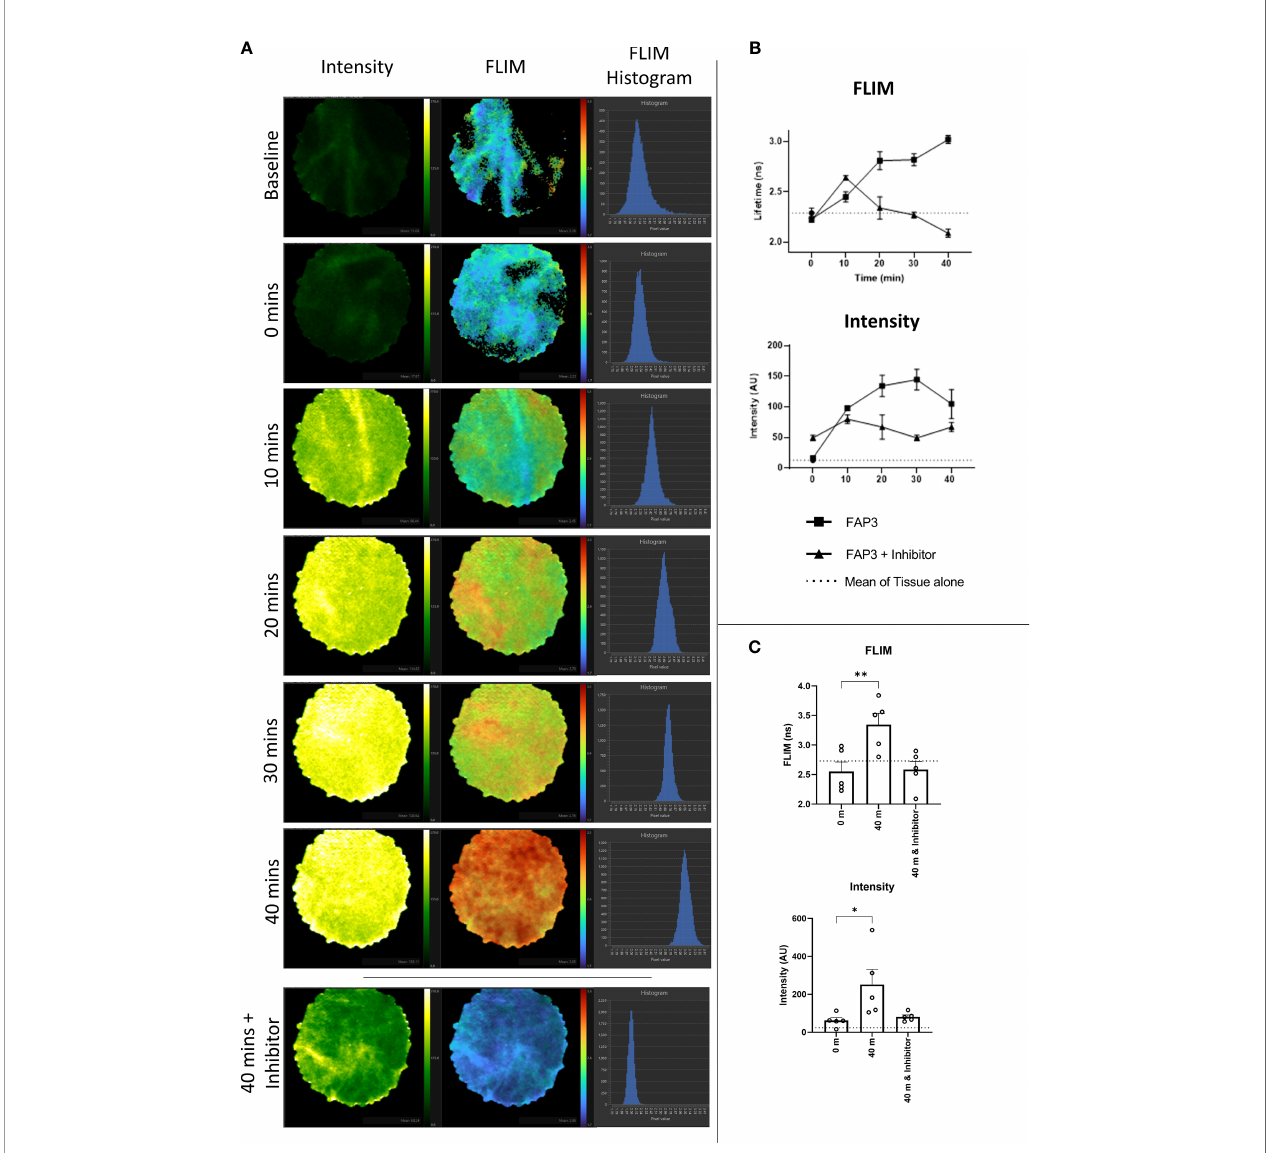
FIGURE 5 | Fluorescence lifetime imaging in NSCLC tissue using FAP3 probe and a clinically approved FLIM system. (A) Representative images showing the change in fl uorescence intensity and lifetime after 488nm excitation of a NSCLC tumor tissue sample over time when incubated with FAP3 at 5µM, with lowest panel demonstrating the late time point with presence of the inhibitor Talabostat; (B) Representative plots showing the change in intensity and fl uorescence lifetime over 40 mins on a NSCLC tissue sample; (C) Aggregate analysis across 5 NSCLC samples at 40 minutes demonstrating a signi fi cant increase in fl uorescence lifetime and intensity, with inhibition in the presence of Talabostat. N=5, analysis by paired t-test, *p < 0.05, **p <